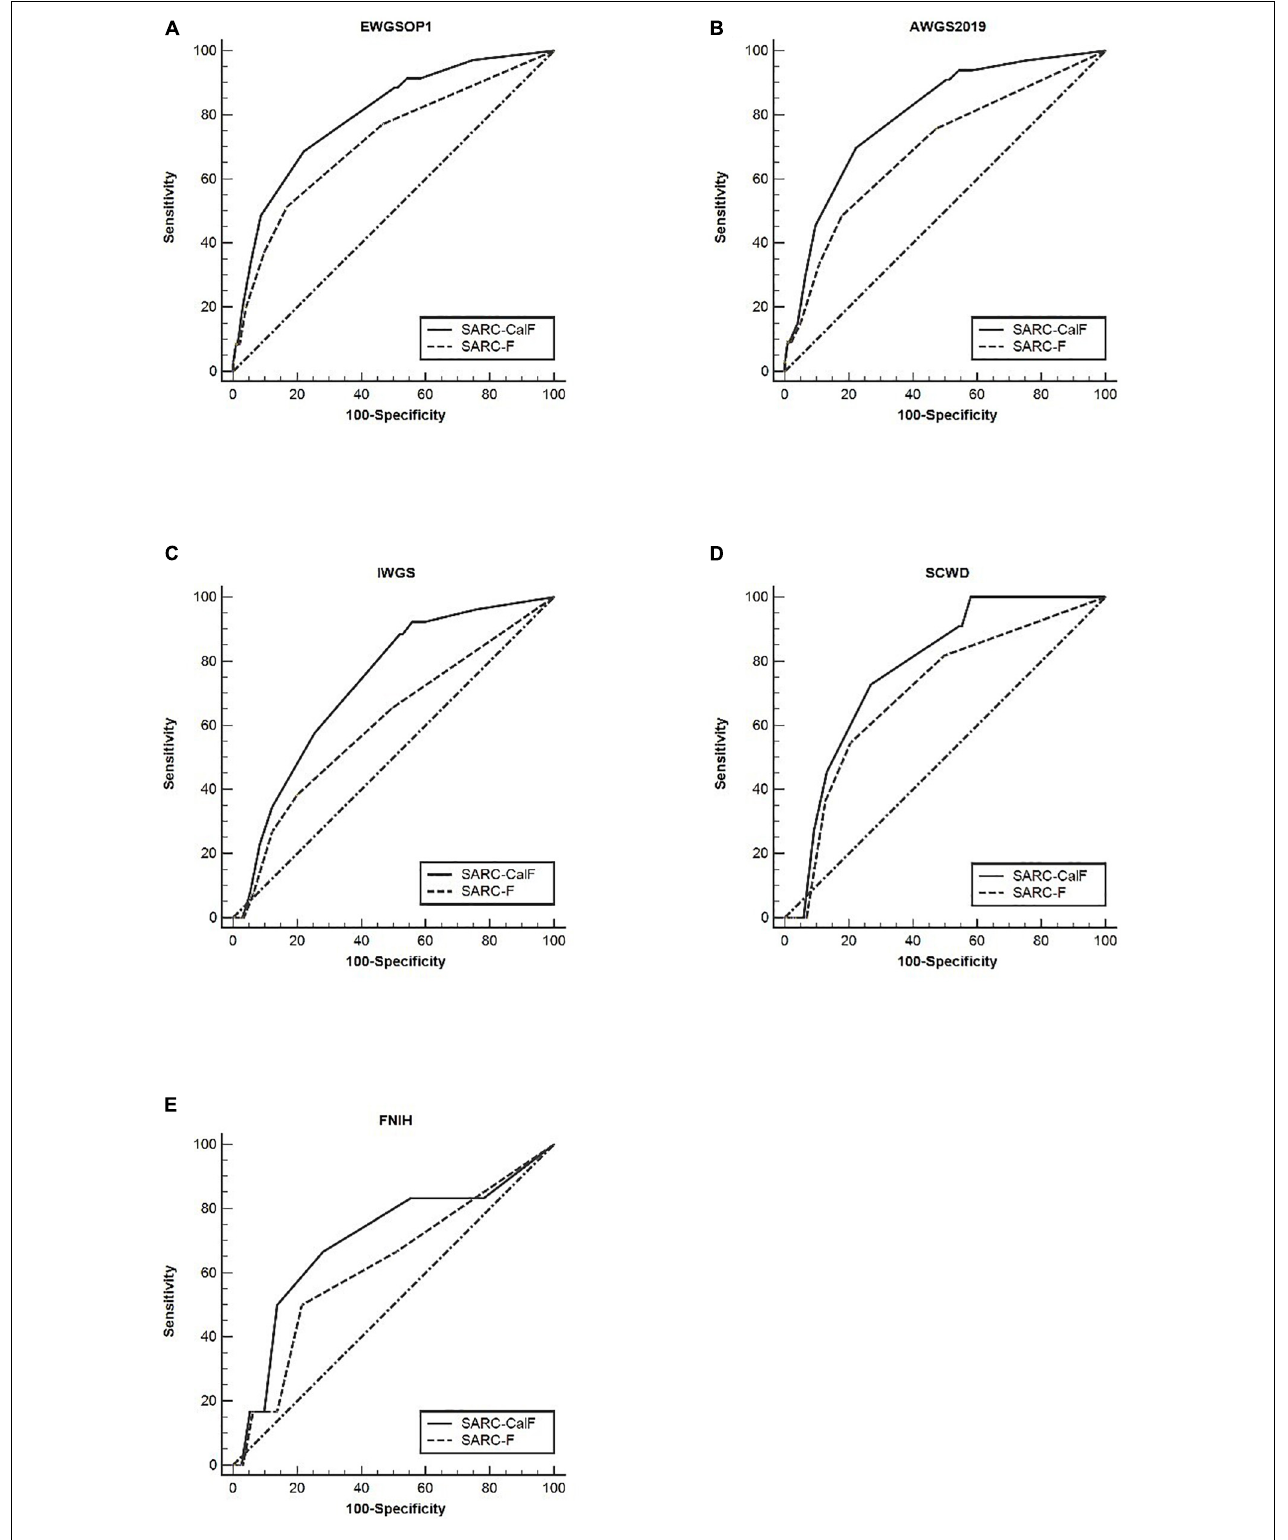
FIGURE 3 | The ROC curves of SARC-F and SARC-CalF compared with various reference standards in women: (A) sarcopenia according to the EWGSOP1 criteria; (B) sarcopenia according to AWGS2019 criteria; (C) sarcopenia according to IWGS criteria; (D) sarcopenia according to SCWD criteria; and (E) sarcopenia according to FNIH